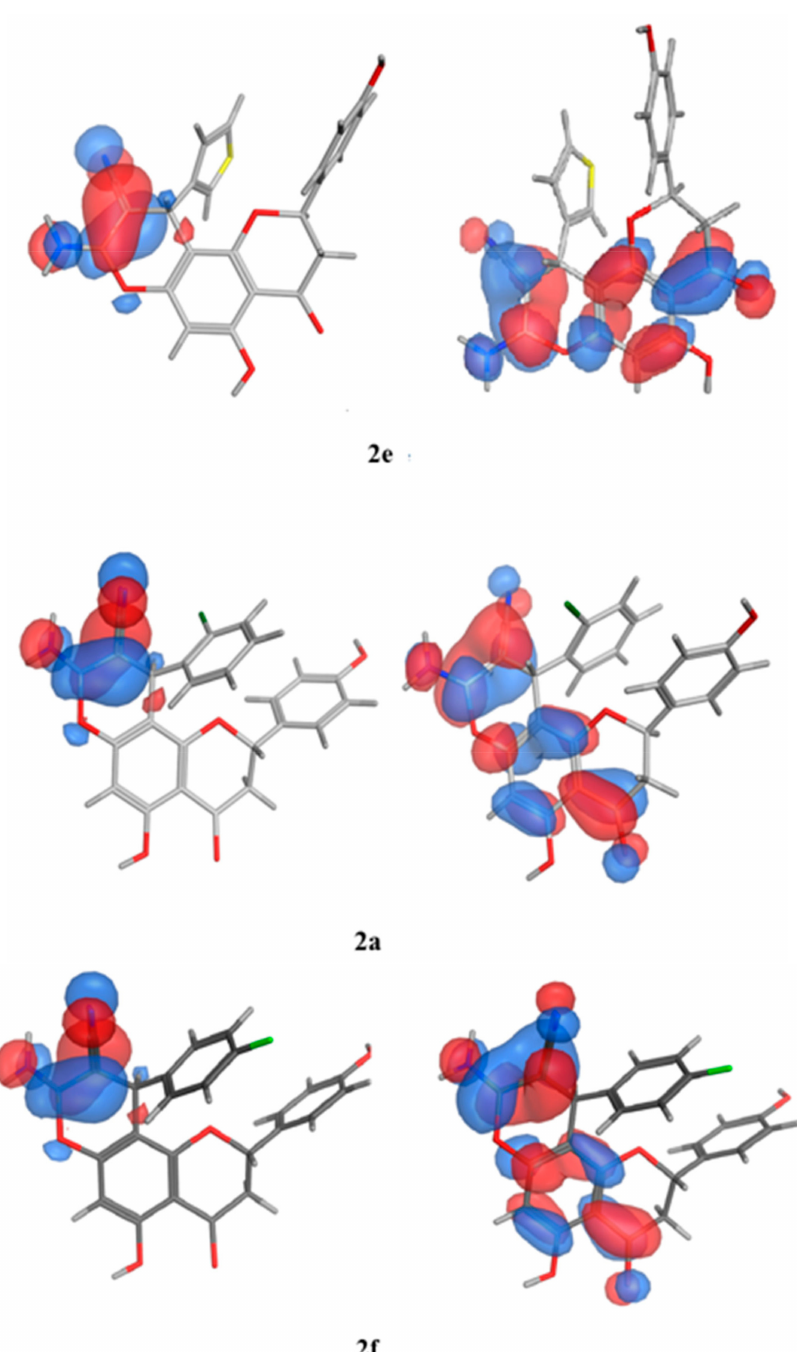
Figure 11. Molecular orbital spatial distribution and localization for the HOMO and LUMO of three representative compounds ( 2e , 2a , 2f ). (The compound structures in this figure are 3D molecular structures where blue color is associated with nitrogen, grey with carbon, red with oxygen, yellow with sulfur, white with hydrogen and green with halogen